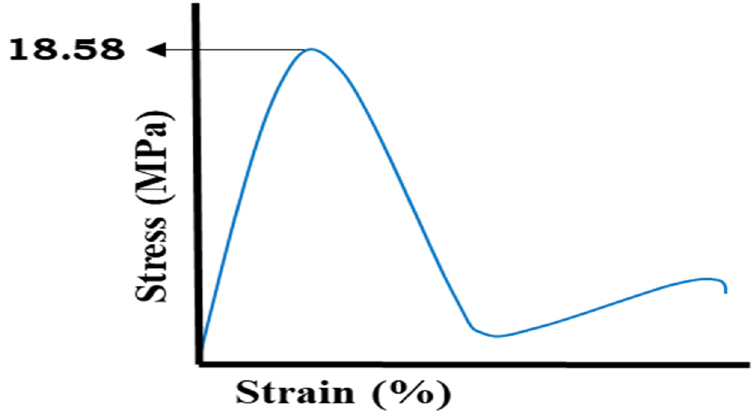
Figure 11. Tensile stress-strain curve .